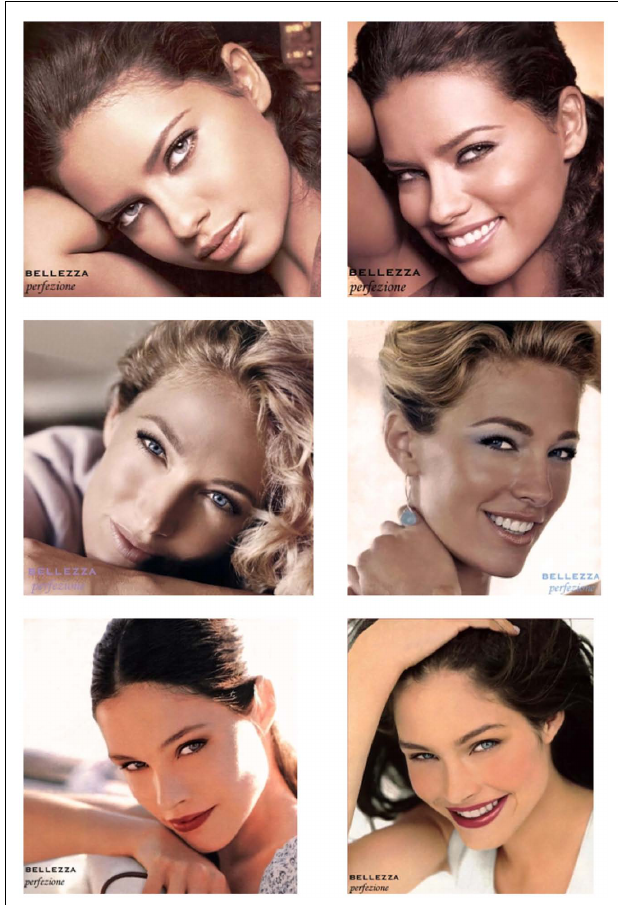
FIGURE 1 | Representative advertisements employed in the current investigation showing model pairs in LA (left side) and HA (right side)